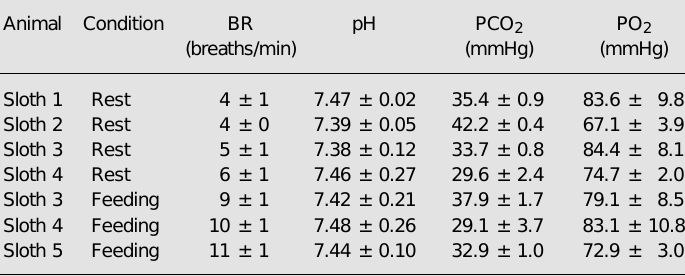
Table 2. Breathing rate (BR) and arterial pH, PCO 2 and PO 2 of unanesthetized sloths ( Bradypus varie- gatus ) at rest and during feeding.